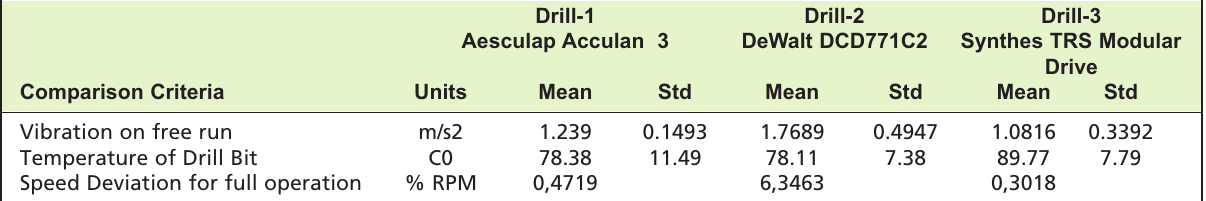
Vibration on free run, temperature of drill bit and Speed deviation for full operation measurements Table IV: